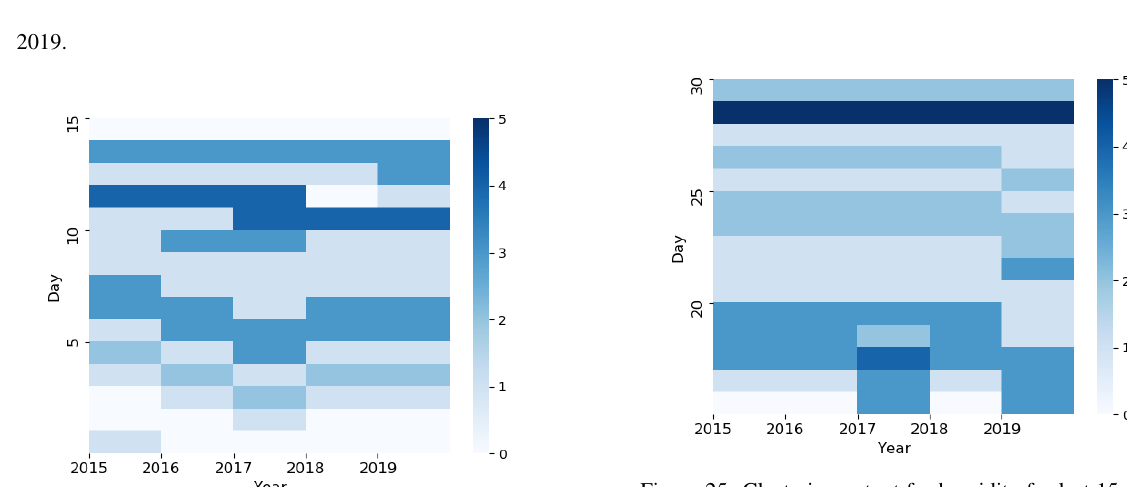
Figure 25: Clustering output for humidity for last 15 days in Q 2 over 2015 to 2019.